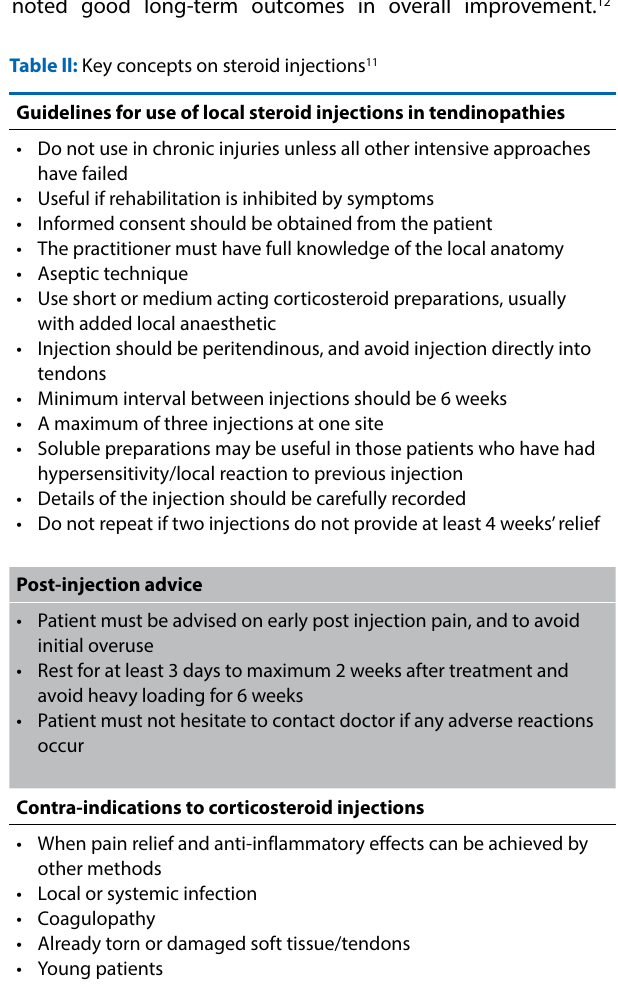
Table ll: Key concepts on steroid injections 11